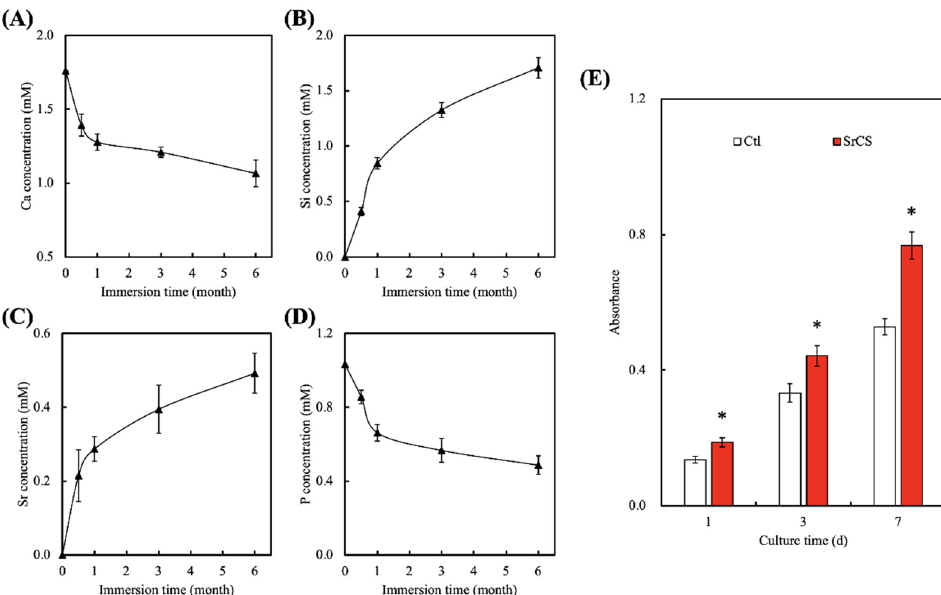
Figure 4. ( A ) Ca, ( B ) Si, ( C ) Sr, and ( D ) P ion concentrations in DMEM after immersion for different durations. ( E ) The proliferation of encapsulated hGF cultured under one-layer or bi-layer scaffolds for various time-points. * indicates significant difference ( p < 0.05) from Ctl group. Data presented as mean ± SEM, n = 6 for each group.